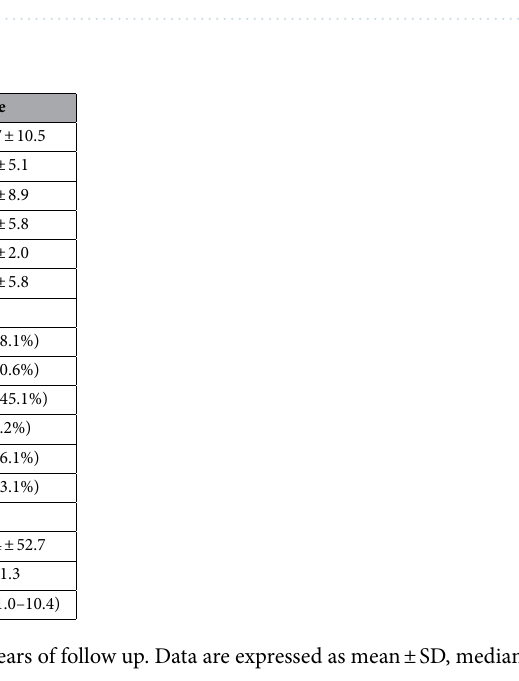
Table 2. Baseline clinical and laboratory data of the enrolled group. Data are expressed as mean ± SD, median (range), or number (%).